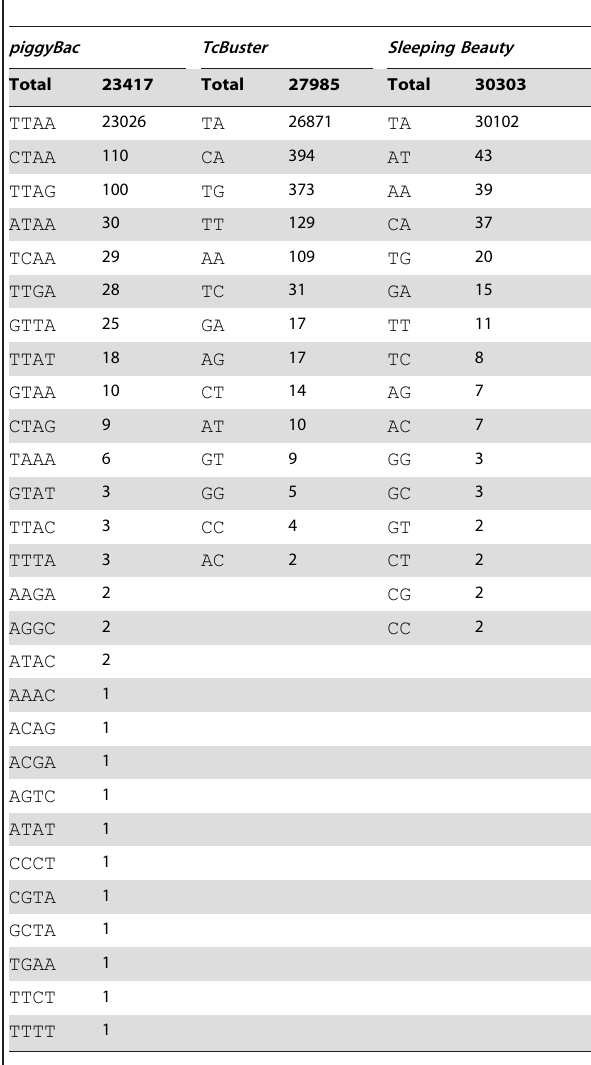
Table 1. The distribution of nucleotide sequences found at transposon insertion sites in HEK-293